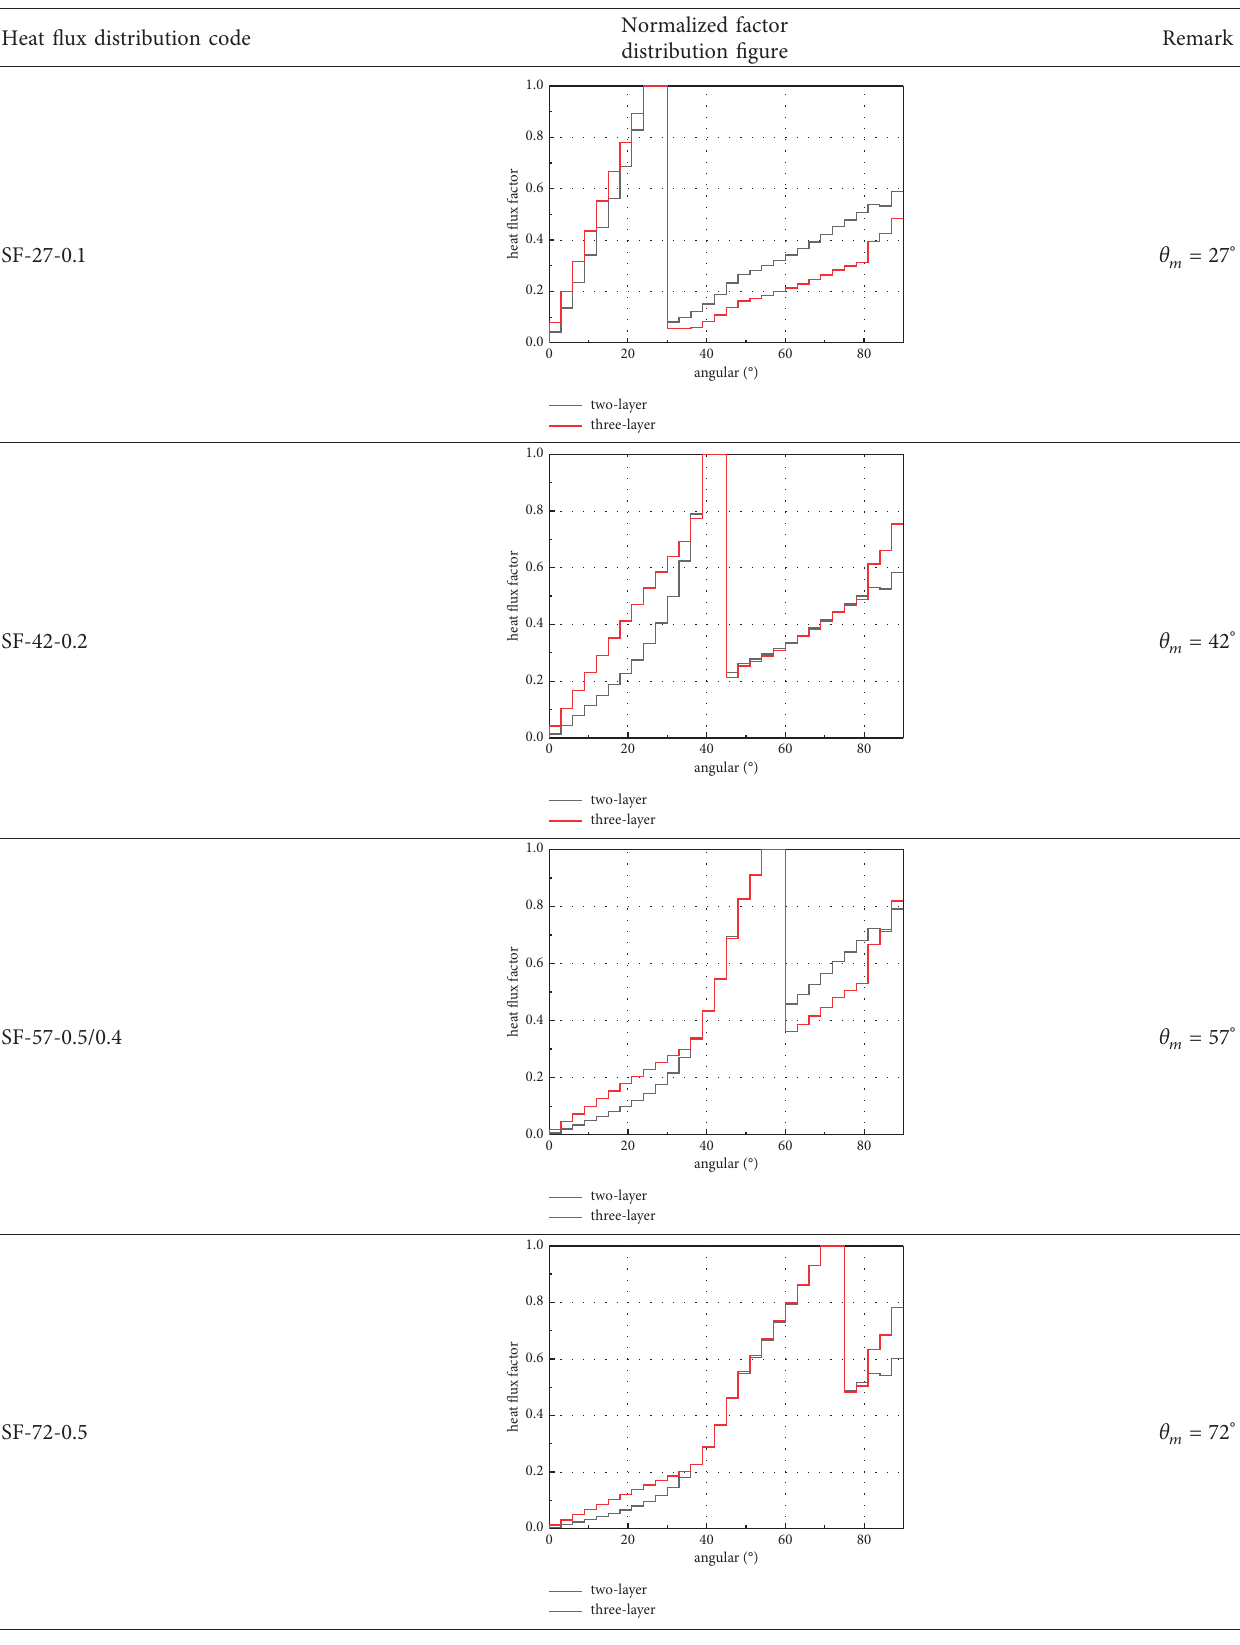
Table 1: Heat flux distributions for different molten pool